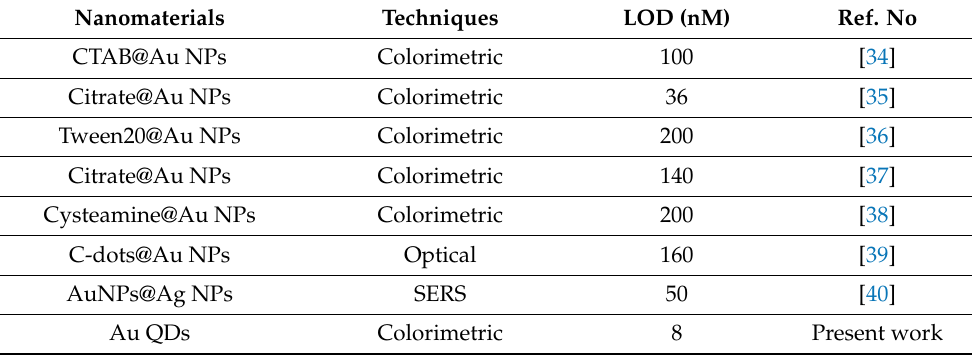
Table 2. Comparative analysis of the proposed